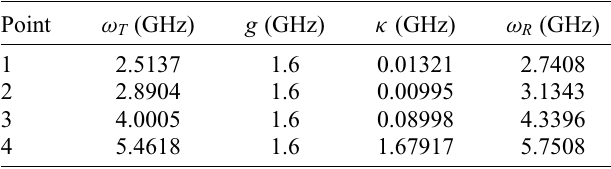
TABLE I. External circuit parameters for nonreciprocal